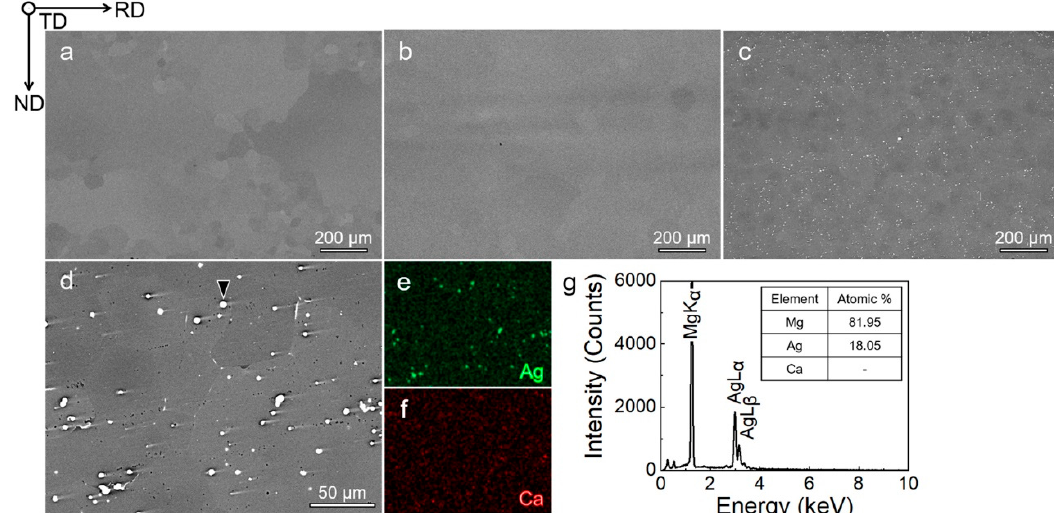
Figure 6. Backscattered electron (BSE) images showing microstructures of T4-treated ( a ) Mg–1.5Ag– 0.1Ca, ( b ) Mg–6Ag–0.1Ca, and ( c ) Mg–12Ag–0.1Ca alloy sheets. ( d ) BSE image, and corresponding ( e ) Ag and ( f ) Ca elemental maps obtained from the Mg–12Ag–0.1Ca alloy sheet. ( g ) EDS spectrum obtained from a second phase particle (marked with a triangle) in ( d ).